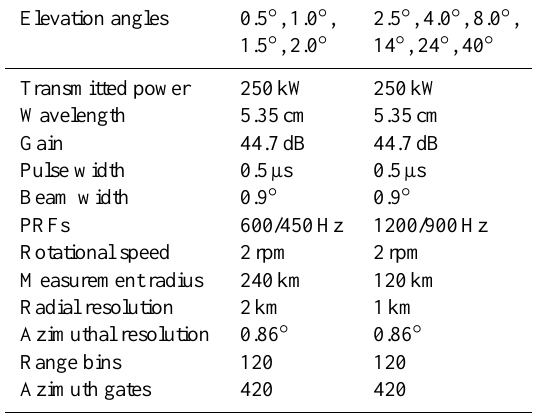
Table 2. Technical characteristics of the Swedish weather